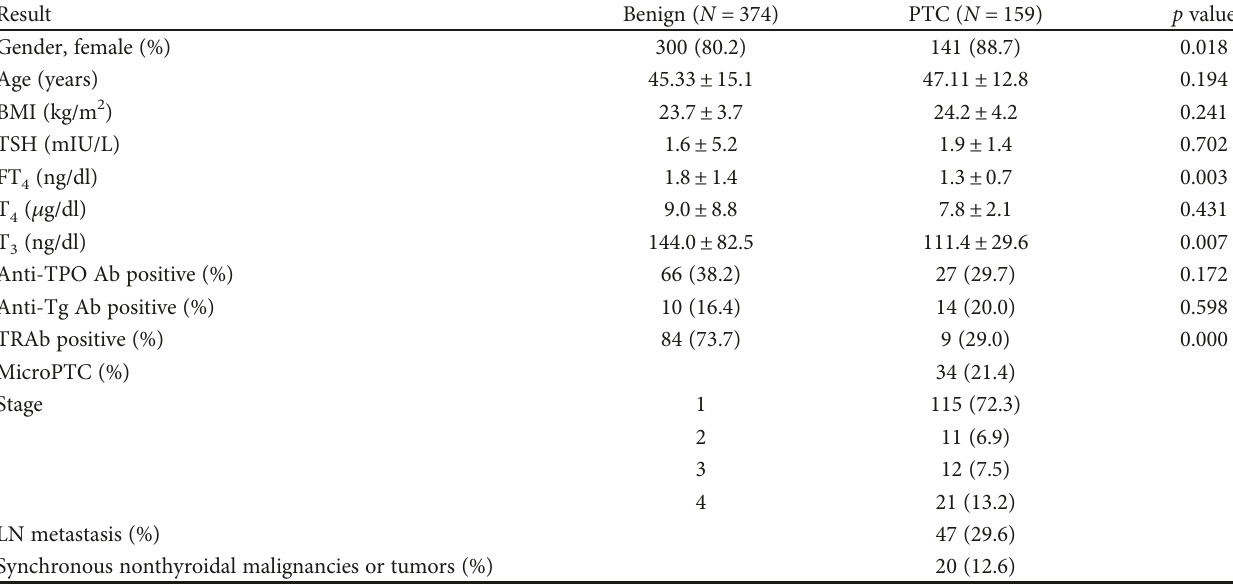
Table 1: Clinicohistopathological characteristics according to pathological results of patients enrolled in the study. Result